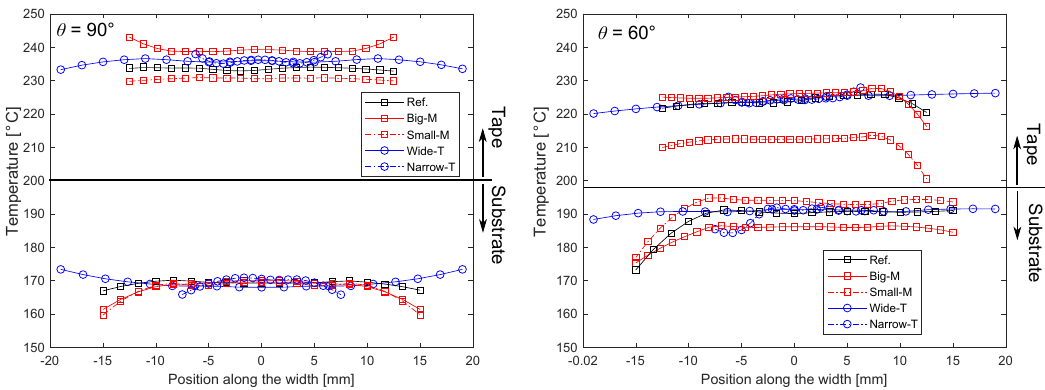
Figure 16. Temperature distribution at the nip line for each case at θ = 90 ◦ ( left ) and 60 ◦ ( right ). (For interpretation of the references to color in this figure legend, the reader is referred to the web version of this article).